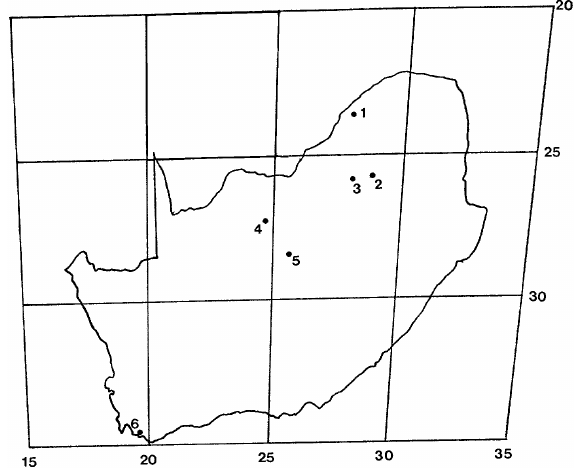
Fig. 1. Map of South Africa, showing the location of the six magne- tometer stations used in the present study. From north to south (low latitude to high latitude): (1) Ellis, (2) Bronk, (3) Lans, (4) Vry, (5) Bos and (6) Herm. The coordinates shown are